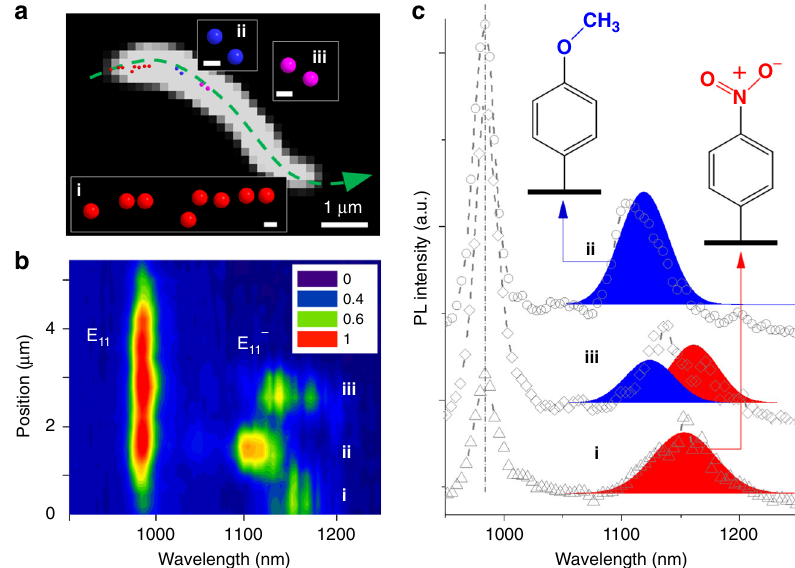
Fig. 4 Resolving and identifying two types of defects along a nanotube. a The super-resolved defect locations superimposed on the E 11 emission of a (6,5)- SWCNT. Three major defect groups can be found. The insets are close looks of the resolved defect locations from these three defect groups. Red, blue and magenta represent 4-nitroaryl, 4-methoxyaryl and mix of the two defect types, respectively (scale bar 100 nm). b Spatially and spectrally correlated PL map along the nanotube centerline as indicated by the green dashed line in ( a ). The y-axis represents the physical positions on the centerline, starting from the left nanotube end. Three defect sites with emission wavelengths in the range of 1080 to 1200 nm can be identi fi ed, which spatially correspond to the three super-resolved defect groups in ( a ). c PL spectra from the three identi fi ed defect sites. Site i and ii are 4-nitroaryl and 4-methoxyaryl defects, respectively, and site iii contains